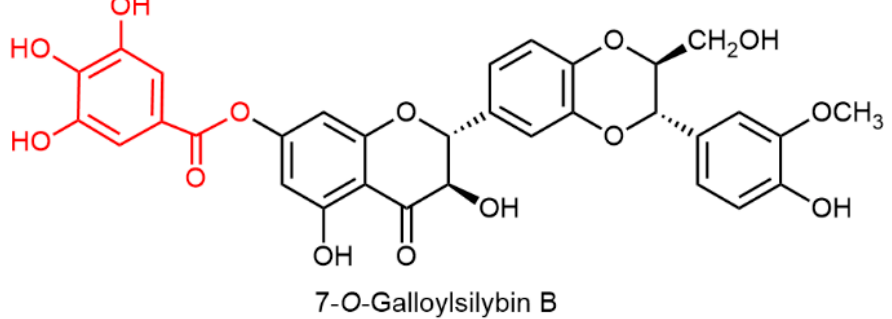
Figure 12. Structure of 7- O -galollylsilybin B, a potent antiangiogenic compound [99]. Serine/threonine-protein kinase B-Raf (BRAF kinase)—the product of proto-onco- gene B-Raf and SMO protein (G protein-coupled receptor—a component of the hedgehog signaling pathway) are two major targets in current anticancer therapy. In silico docking similar docking scores to the binding sites of BRAF and SMO kinases similarly to vemu- rafenib and vismodegib that are established inhibitors of the proteins used in cancer treat- ment [136]. This finding was confirmed by in vitro studies with BRAF kinase where de- hydrosilybin B showed the best inhibitory activity (IC 50 = 25 µM), ca. three times better than its A stereomer and both silybins A and B. Strong dose-dependent binding of both dehydrosilybin A and B was also demonstrated in the BODIPY-cyclopamine SMO bind- ing assay. This combined in silico / in vitro approach is a nice demonstration of the molec- ular effect of 2,3-dehydrosilybin B. The cytotoxicity experiments further confirm the cyto- toxic properties of the compounds in malignant skin cell lines by showing higher activity in A-375 cells than in A-431 and HaCaT [136]. In addition to natural flavonolignans, their derivatives, including those stemming from optically active parent compounds, were also tested for the inhibition of cancer cell lines. A series of silybin B methyl derivatives were evaluated for their antiproliferative effect against human prostate cancer lines DU-145, PC-3, and LNCaP cells, and also hu- man hepatoma line Huh7.5.1. All the methyl derivatives were equal to or more potent than the parent compound, with 7,20- O -dimethylsilybin B being the most potent deriva- tive (ca 6 × more potent) [97]. It was found that 7- O -Methylation of all major flavo- nolignans of silymarin significantly increased their cytotoxicity in a human Huh7.5.1 he- patoma cell line, with the average fold change being approximately 6, lowering the IC 50 from the average range of ~70 µM in the parent flavonoids to ~10–15 µM in the respective 7- O -methyl derivatives [96].